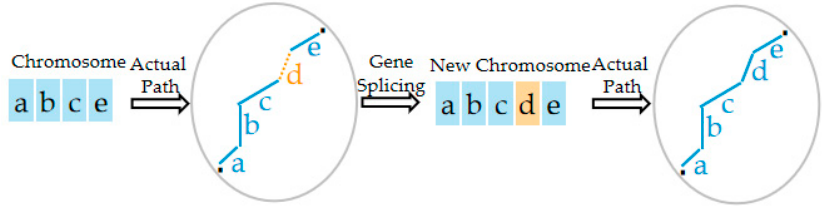
Figure 4. Schematic diagram of gene splicing